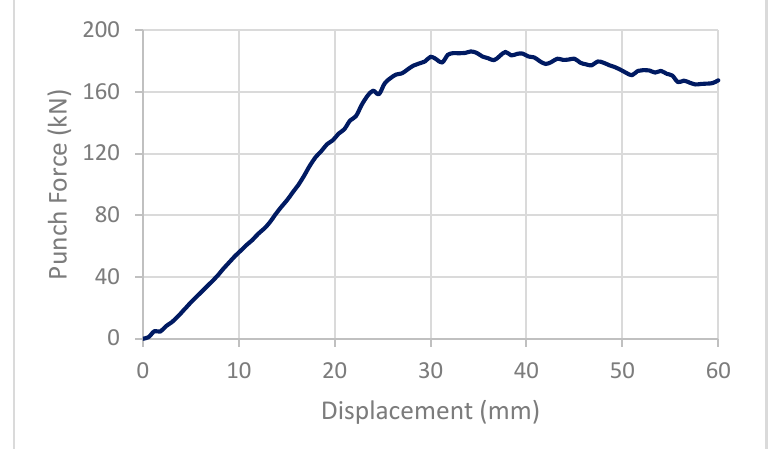
Figure 10. Punch force during forming process.